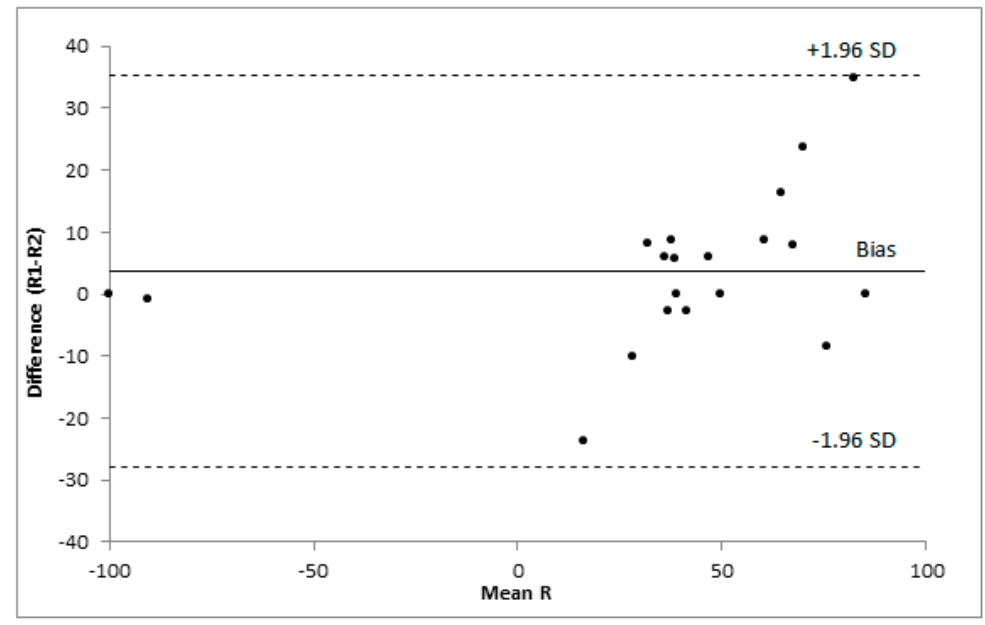
Figure 2. Bland–Altman plot: graphical display of the means against their respective paired differences, the Bland–Altman limits of agreement (dashed lines), and the bias, i.e., estimated mean difference (solid line).